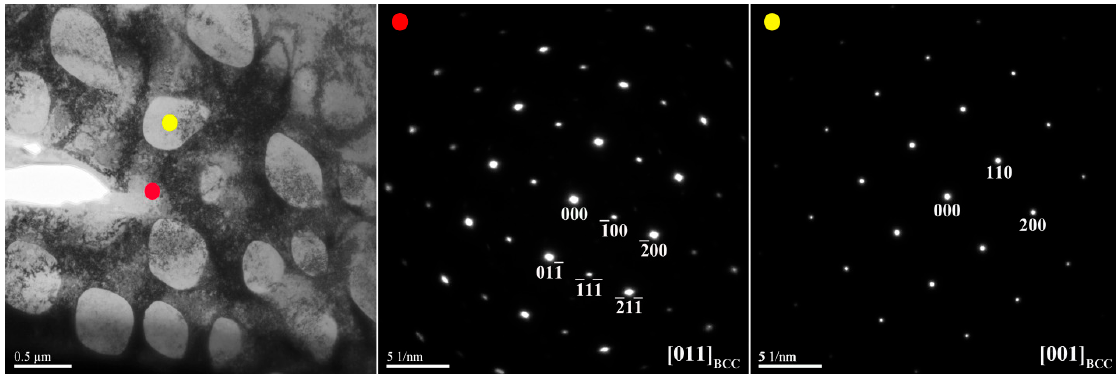
Figure 9. TEM bright-field image and SAED patterns of dendrite for the X 1 as-cast alloy (red dot: ordered BCC; yellow dot: BCC).